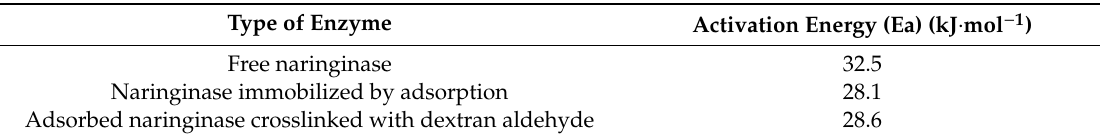
Table 4. Summary of activation energy of free naringinase, naringinase immobilized by adsorption and naringinase crosslinked with dextran aldehyde.